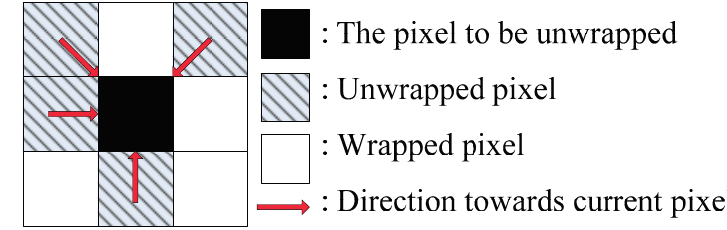
Figure 1. Prediction principle of two-dimensional